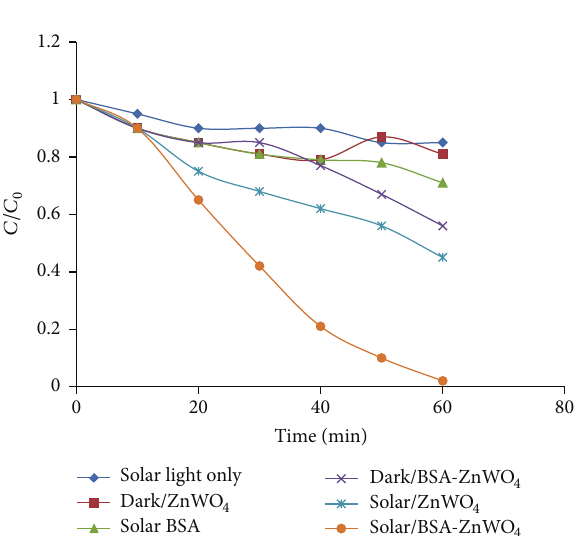
Figure 7: Degradation of MB under different reaction conditions: [MB] = 6.0 × 10 −5 moldm −3 , catalyst dosage = 50mg/100mL, pH = 5, temperature: 30 ± 0.5 ∘